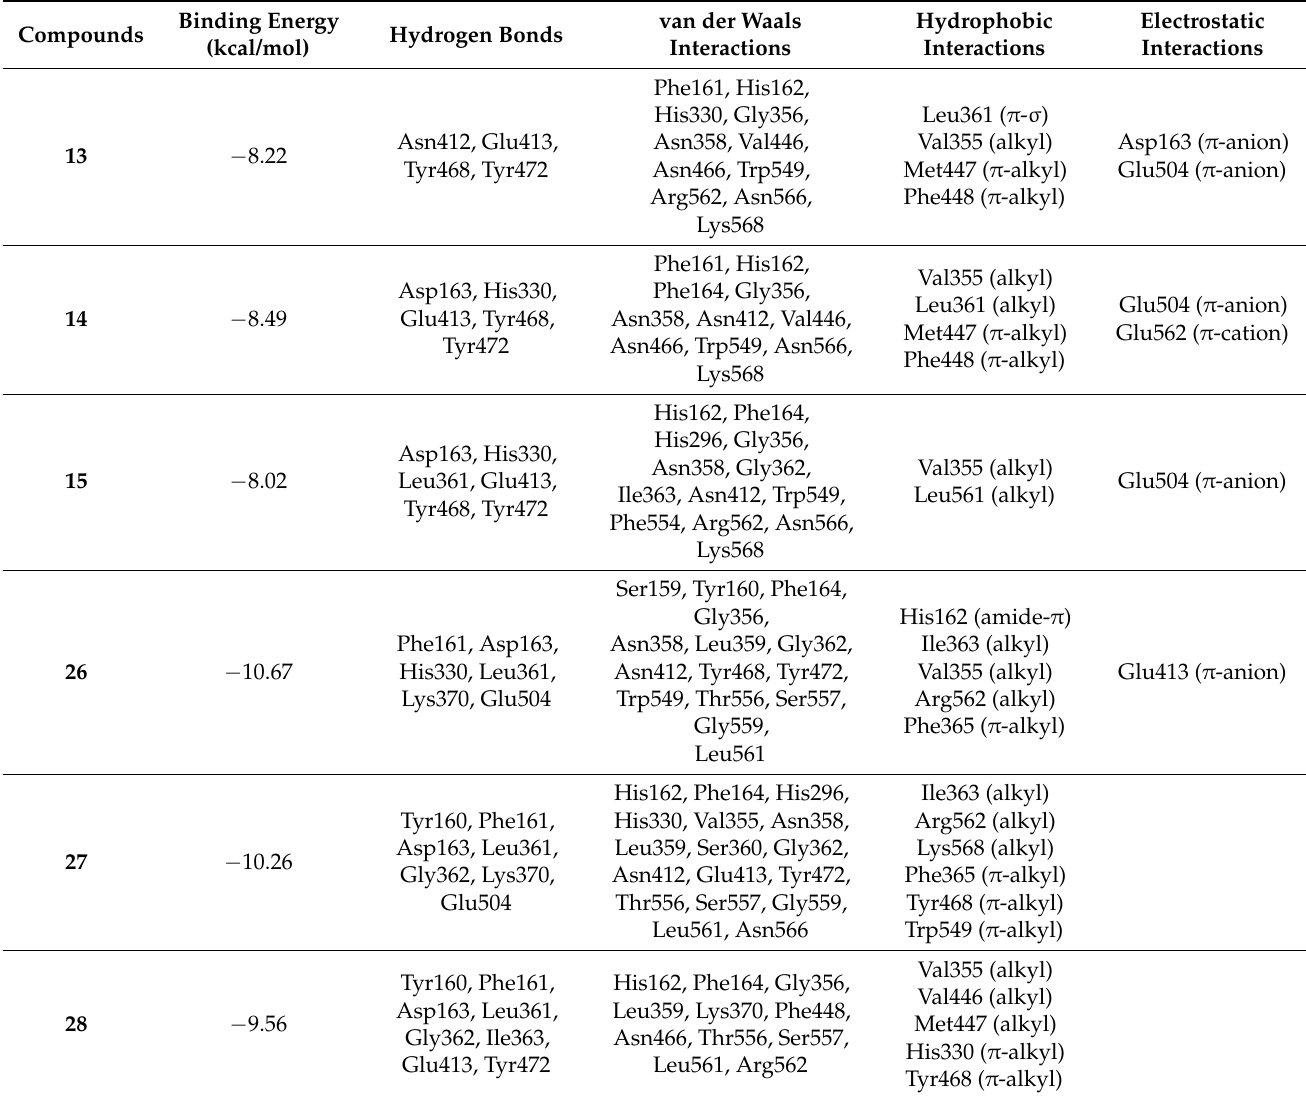
Table 3. Docking energies and binding site interactions of active phloroglucinols 13 – 15 and 26 – 28 with β